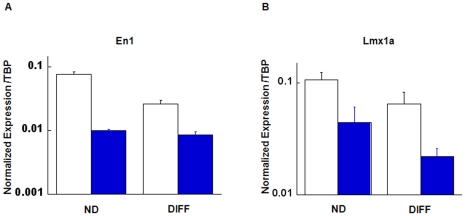
Quantitative PCR analysis of the neural transcription factors En1 and Lmx1a.In both the undifferentiated basal state and after differentiation, there is marked reduction of expression of both transcription factors in the knockdown cells (filled columns). Error bars (Mean + SEM).